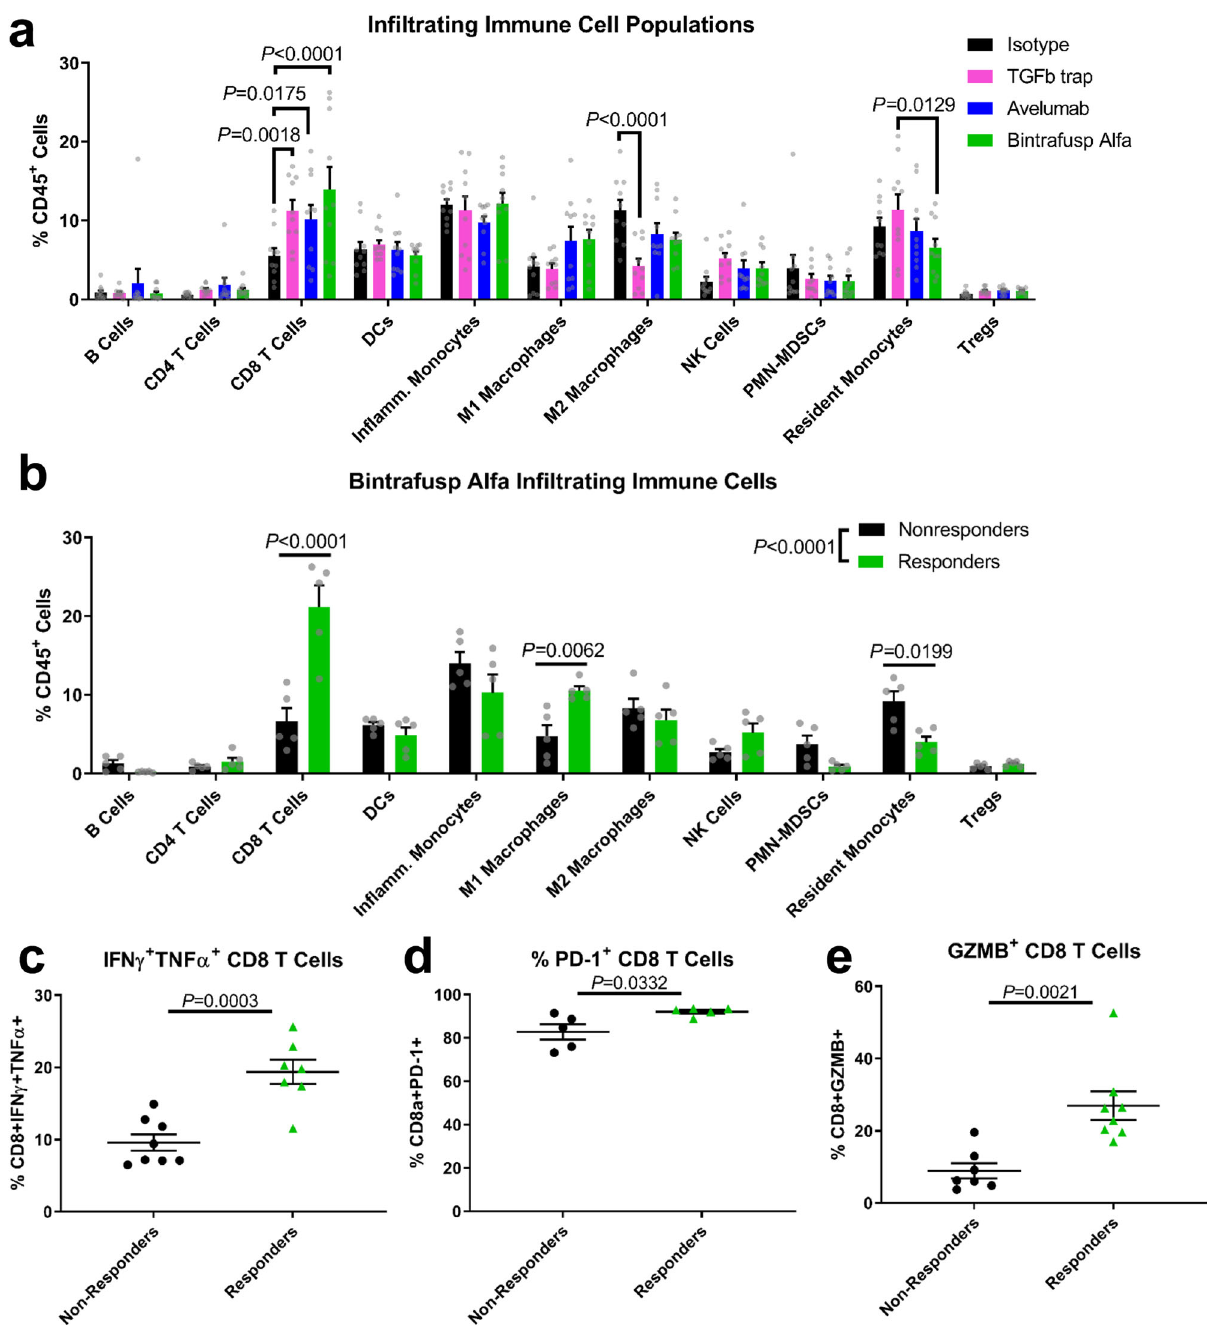
Fig. 4 Responders to bintrafusp alfa have a more immune-permissive microenvironment and increased T cell activation when compared to nonresponders. a In fi ltrating immune cell populations of all mice treated with bintrafusp alfa (green bars, n = 10), its isotype control (black bars, n = 10), anti-PD-L1 (blue bars, n = 10), or TGF β trap (pink bars, n = 10) after mass cytometric analysis and clustering. b In fi ltrating immune cell populations of responder (green bars, n = 5) and nonresponder (black bars, n = 5) subpopulations of bintrafusp alfa-treated mice, with population differences determined as in ( a ) ( P < 0.0001, F = 11.17, df = 10), with P -values for signi fi cant multiple comparisons as shown. c PD-1 expression on CD8 T cells from ( b ) as quanti fi ed by mass cytometry ( n = 5). Tumor digests from mice treated as in ( a ) were treated for 4 h with brefeldin-A, ionomycin, and PMA and the proportion of d CD8 + IFN α + TNF α + and e CD8 + Granzyme B + cells are shown ( n = 7 nonresponders in black, n = 8 responders in green). Population differences for ( a ) ( P < 0.0001, F = 2.617, df = 30) and ( b ) ( P < 0.0001, F = 11.17, df = 10) were determined by two-way ANOVA and Sidak ’ s multiple comparisons test with signi fi cantly altered populations as shown. Unpaired two-tailed t tests were performed for ( c – e ), and all error bars represent the